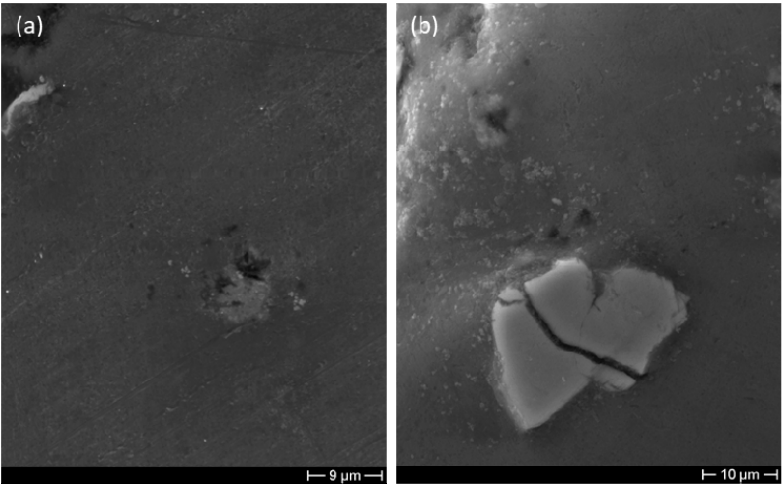
Figure 5. SEM micrographs showing ( a ) an Fe-based intermetallic particle and ( b ) a Ti particle. Materials 2021 , 14 , x FOR PEER REVIEW